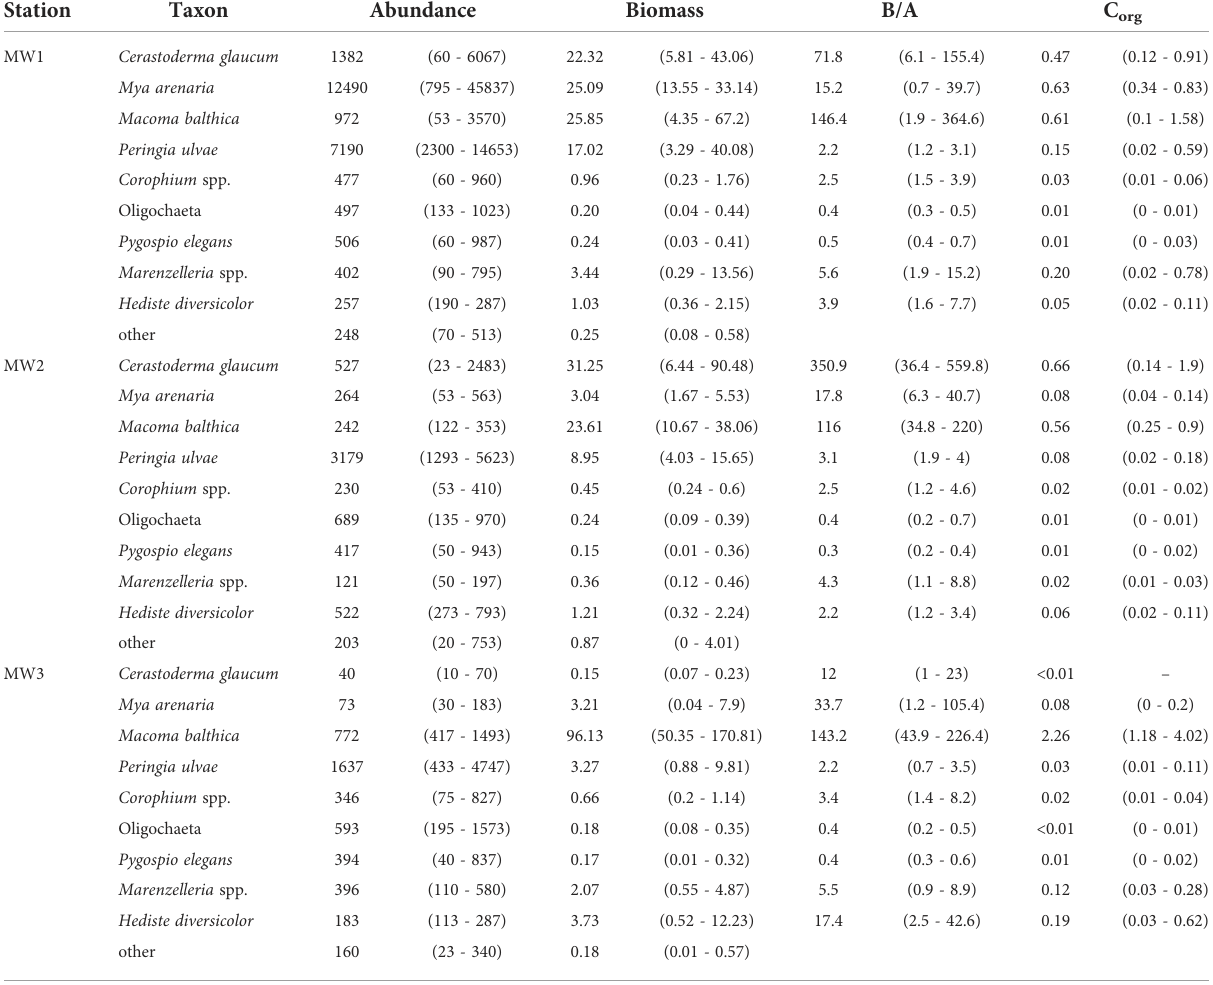
TABLE 3 The mean abundance [ind. m -2 ], biomass [WW g m -2 ], biomass/abundance ratio (B/A) [mg ind. -1 ], and C org [DW g m -2 ; SFDW for mollusks species] of the common benthic taxa at the sampling